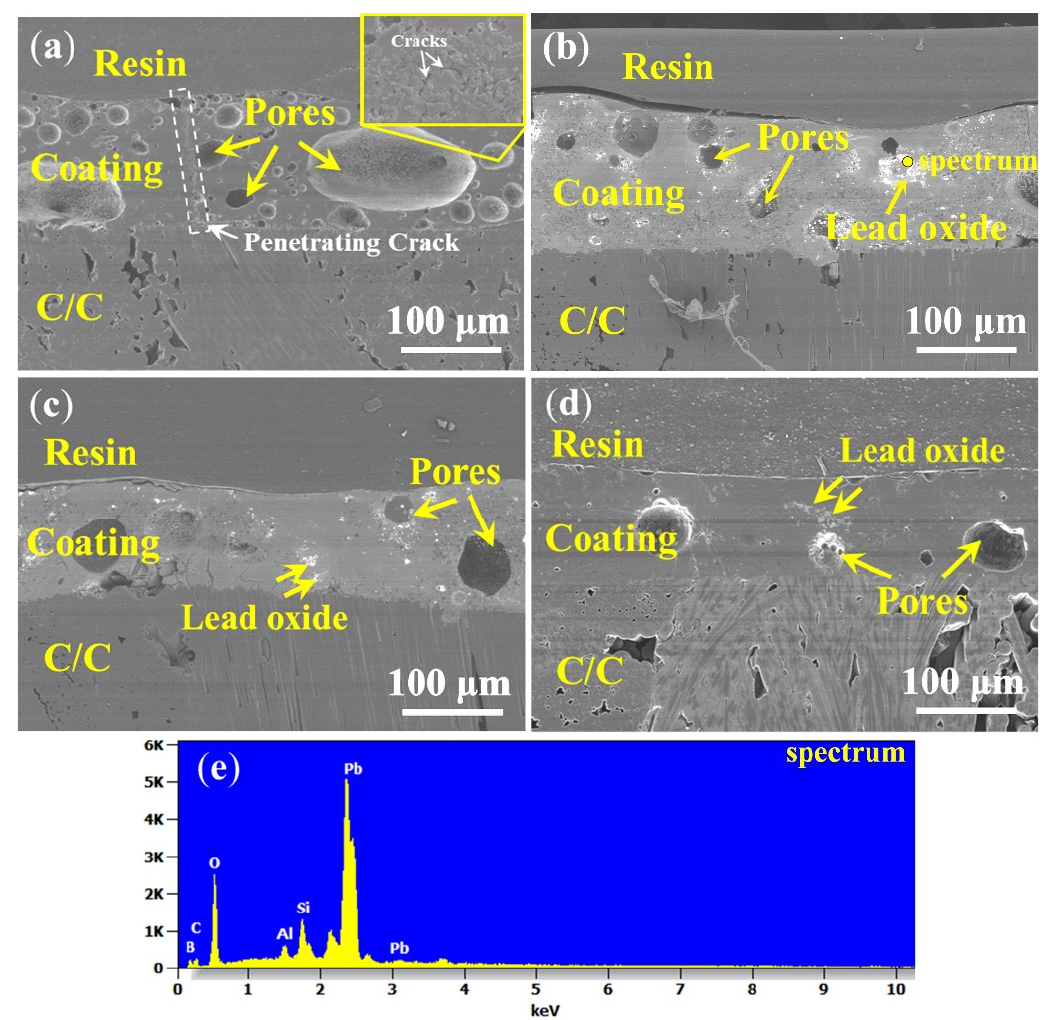
Figure 6. Cross-sectional images of PSN/lead–borosilicate glass–B4C coatings with different lead glass content after 500 °C oxidation for 2 h in air: ( a ) Pb10; ( b ) Pb20; ( c ) Pb30; ( d ) Pb40; and ( e ) EDS result of the point labeled in ( b ).